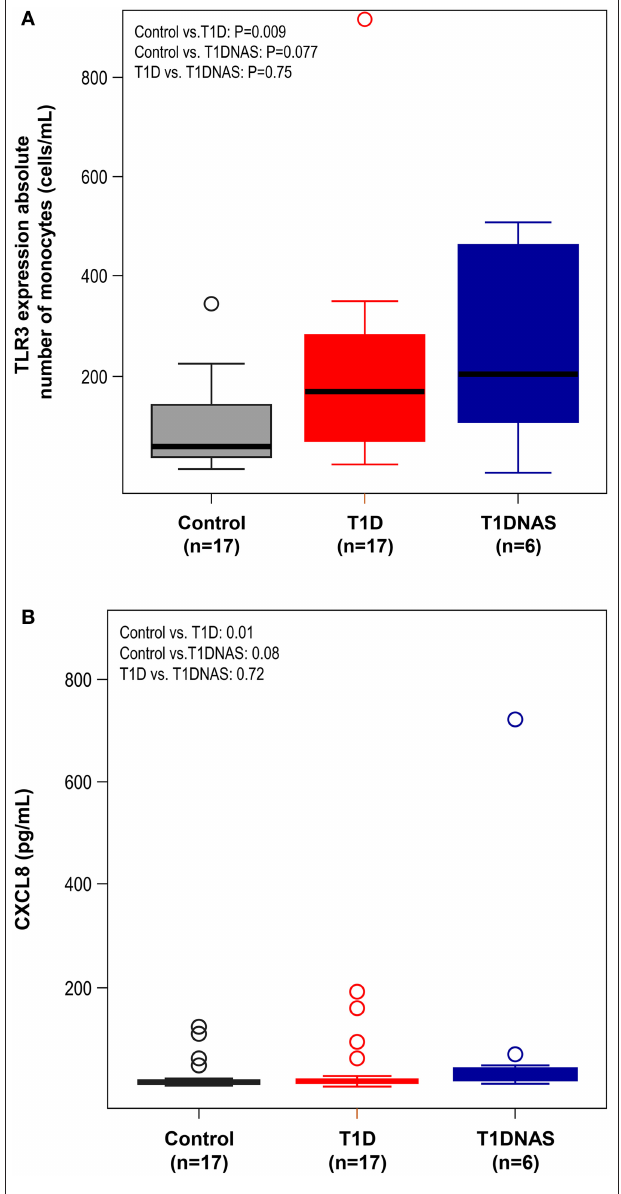
FIGURE 5 | (A) Expression level of TLR3 by absolute number of monocytes (cells/mL) in control subjects ( N = 17), type 1 diabetes patients from multiplex families (T1D) ( N = 17) and their non-affected siblings (T1DNAS) ( N = 6). Control vs.T1D: P = 0.009; Control vs. T1DNAS: P = 0.077; T1D vs. T1DNAS: P = 0.75. (B) Serum concentration of CXCL8 (pg/mL) in monocytes in control subjects ( N = 17), type 1 diabetes patients from multiplex families (T1D) ( N = 17) and their non-affected siblings (T1DNAS) ( N = 6). Control vs.T1D: P = 0.01; Control vs. T1DNAS: P = 0.08; T1D vs. T1DNAS: P = 0.72.